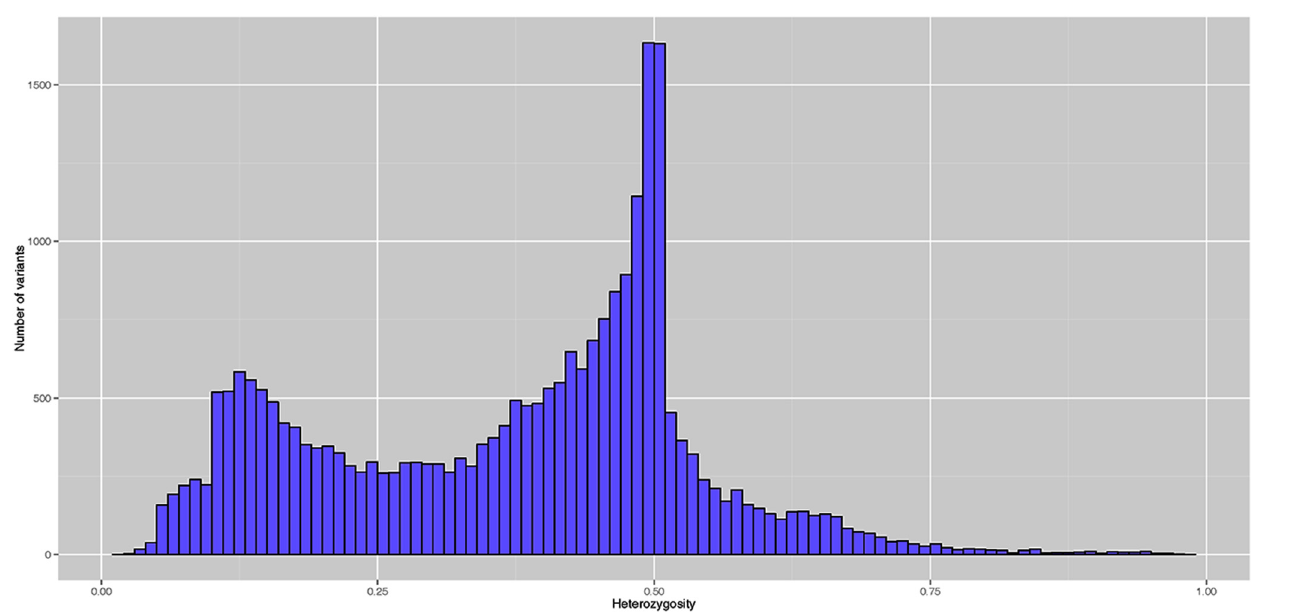
Fig 4. The distribution of heterozygosity of valid variants after genotyping by sequencing